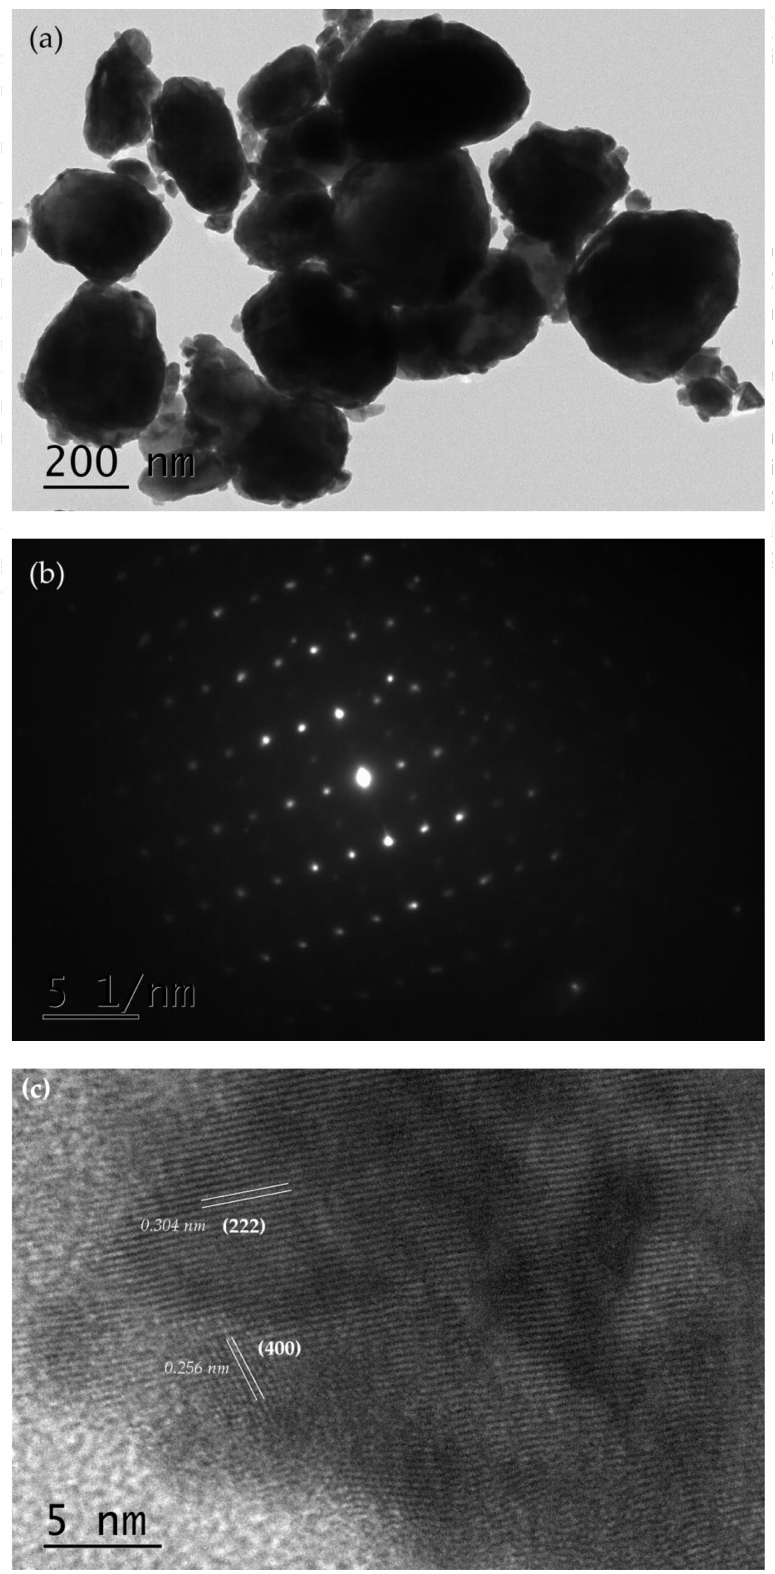
Figure 2. The high resolution TEM picture of BiSnSbO 6 ( a ), the selected area electron diffraction pattern of BiSnSbO 6 ( b ) and the HRTEM image of BiSnSbO 6 with clear lattice fringe spacing ( c